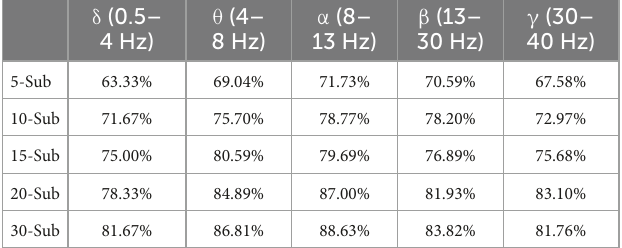
TABLE 3 The classification results of five types of sleep stages by directly extracting features from 5-band EEG.